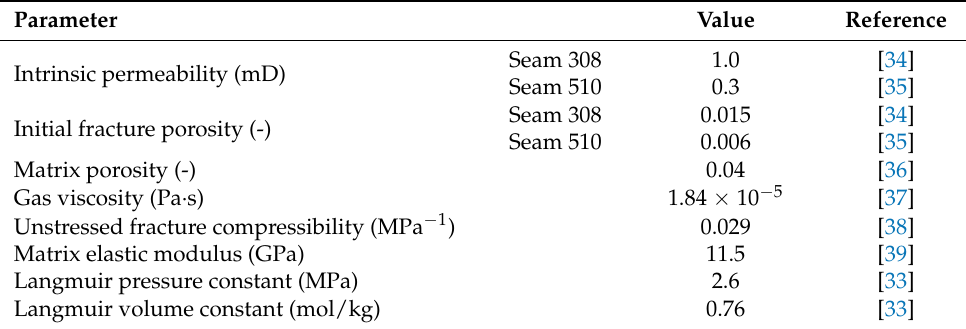
Table 1. Hydrochemical parameters of the near-field model.